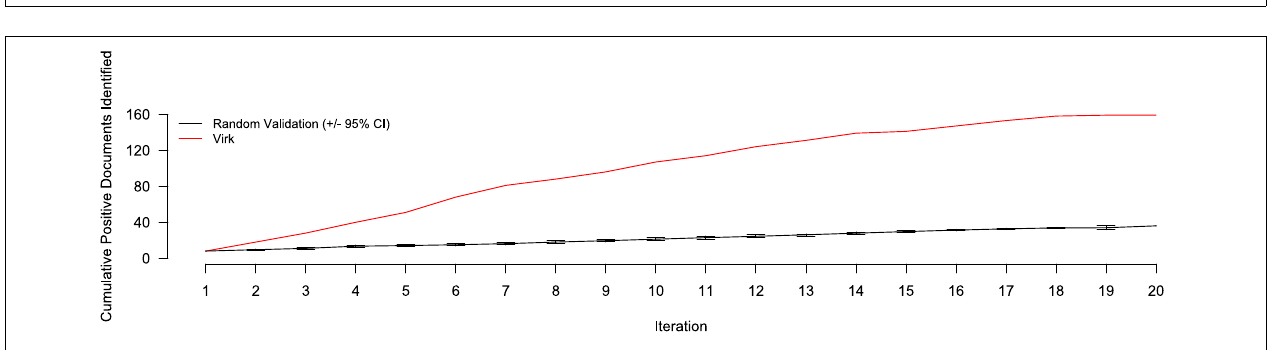
FIGURE 4 | Performance evaluation comparing AUC of the Virk (red line) and Random Validation (black line) systems over iterations of active learning. The Random Validation system AUC was averaged over 10 random